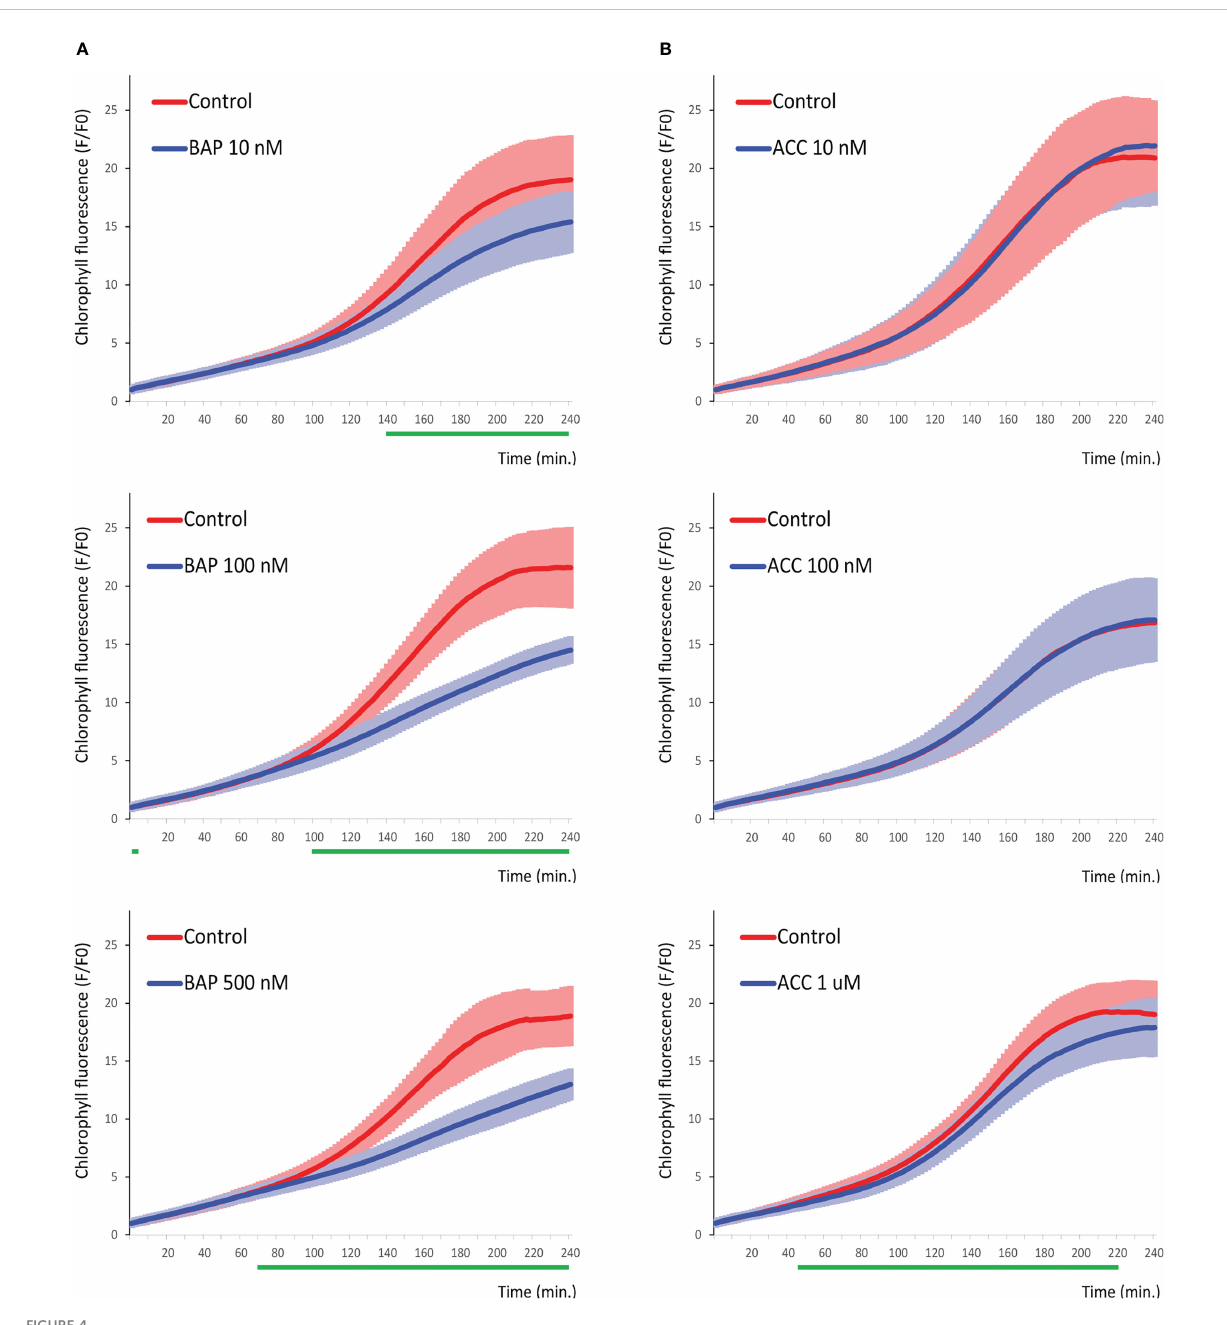
FIGURE 4 Chlorophyll dynamics is negatively regulated in a dose-dependent way by cytokinin and ethylene during the late phase of de-etiolation. Chlorophyll accumulation in 4-days-old etiolated seedlings grown on the media supplemented by (A) 10 nM, 100 nM, and 500 nM BAP and (B) 10 nM, 100 nM, and 1 uM ACC. Data represent the mean values ± SD, n=9 of raw data ( fl uorescence F) normalized to the mean fl uorescence value at T0 (F0). The green lines under the x axis depict time intervals with signi fi cantly different values between WT and the mutant